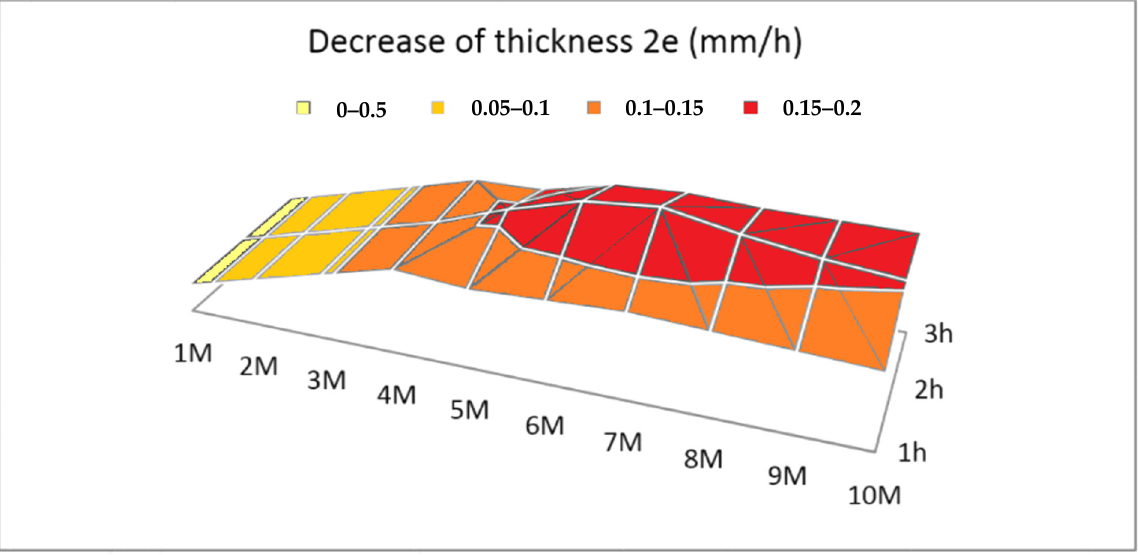
Figure 3. Decrease in the thickness (2e) of an aluminum foil (mm/h) at different molarities, at 25 °C, for 3 h.